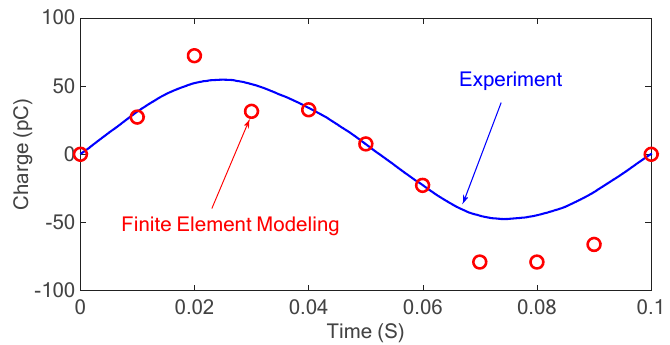
Figure 14. Piezoelectric results of the nanocomposite obtained from simulation and experiments.